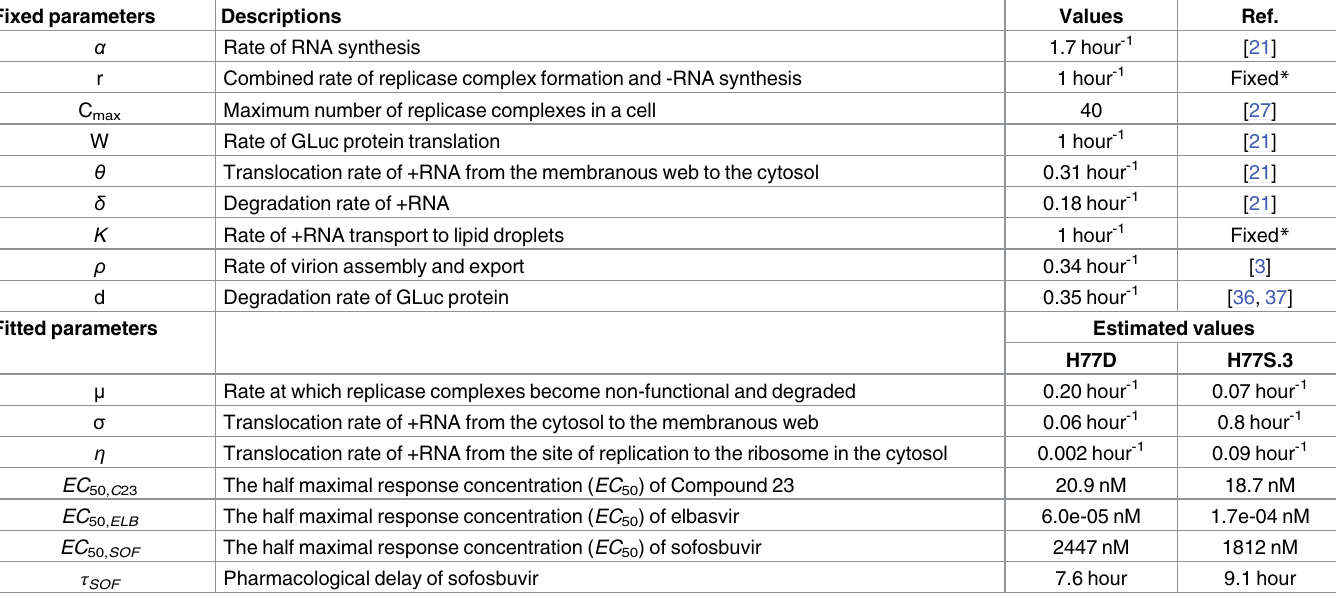
Table 2. Descriptions of parameters and their values in the mathematical